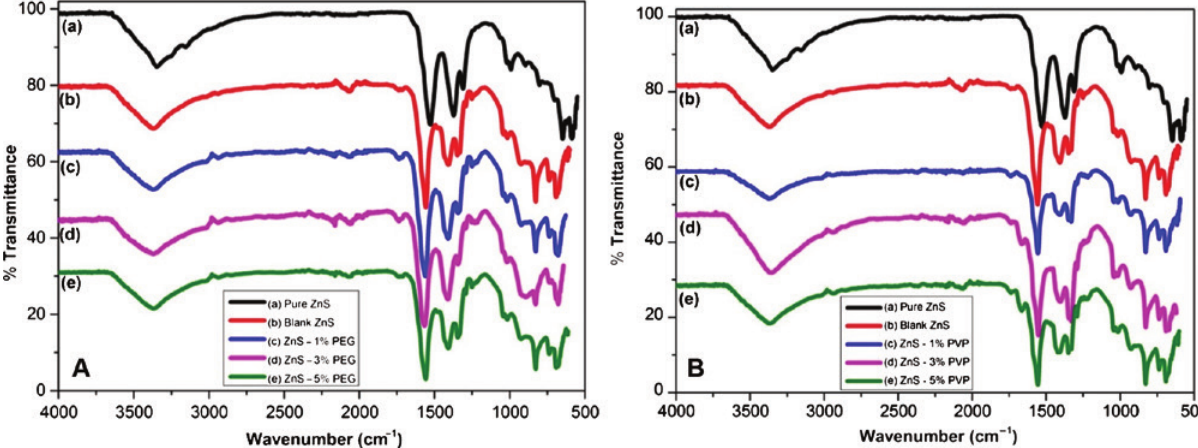
Figure 1: FTIR spectra of the free/uncapped (a), blank (b) 1% (c), 3% (d), and 5% (e) PEG- [A] and PVP- [B] capped ZnS